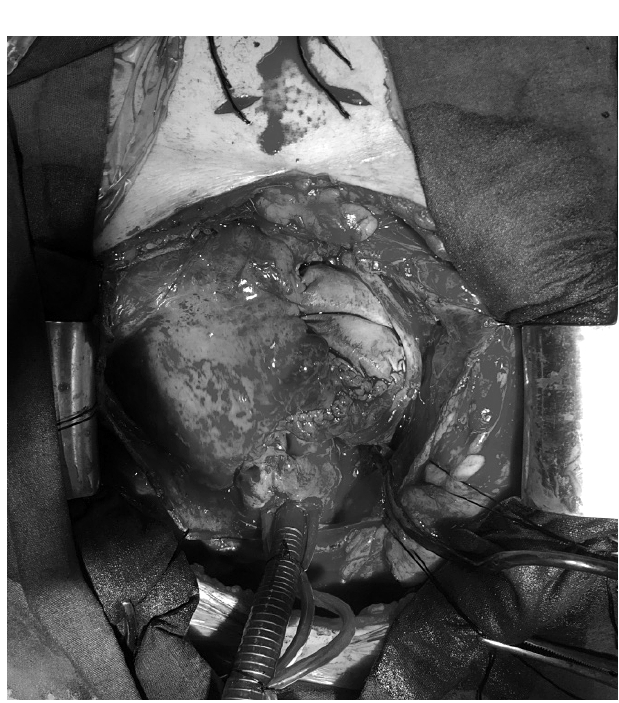
Fig. 5 – Image of patch plasty of right atrium and vein graft to the right coronary artery at the end of